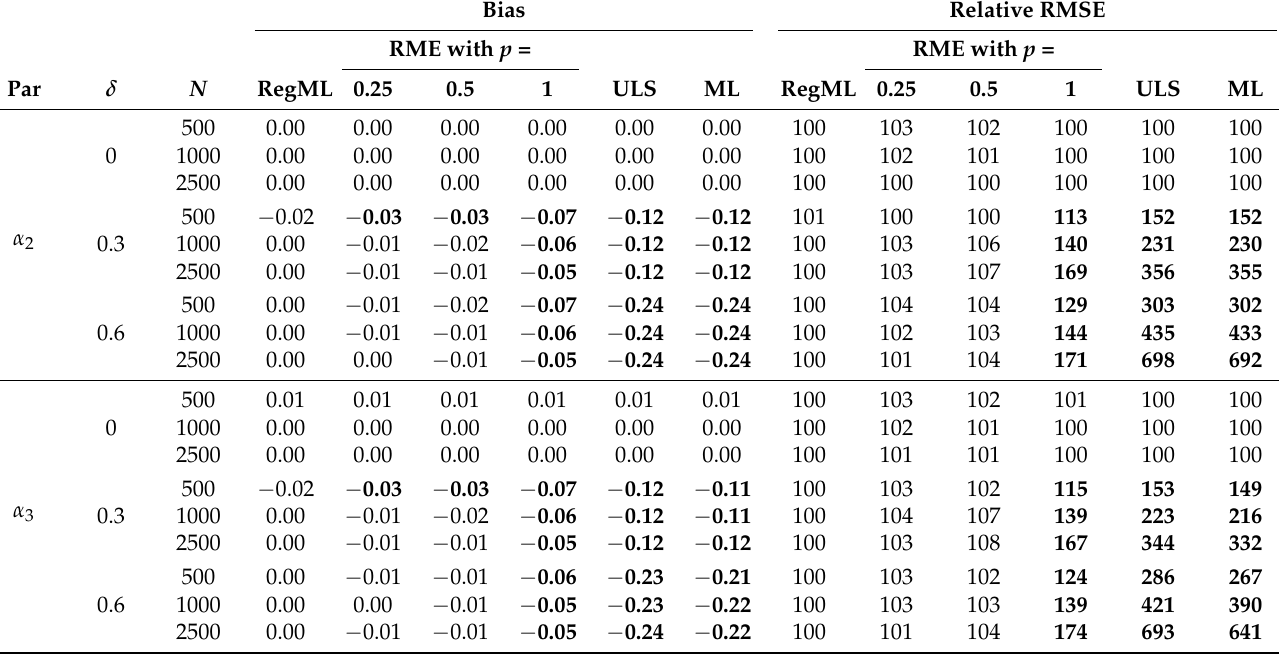
Table 3. Simulation Study 2: Bias and relative root mean square error (RMSE) of model parameter estimates as a function of sample size N and size of DIF effects δ